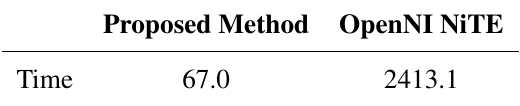
Table 3. Average initial human pose estimation time (unit: ms).